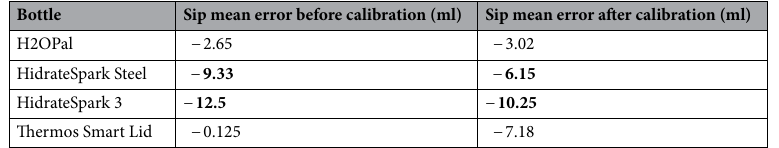
Table 2. Sip mean error before and after calibration for phase 2. Values that were improved after calibration are in bold.